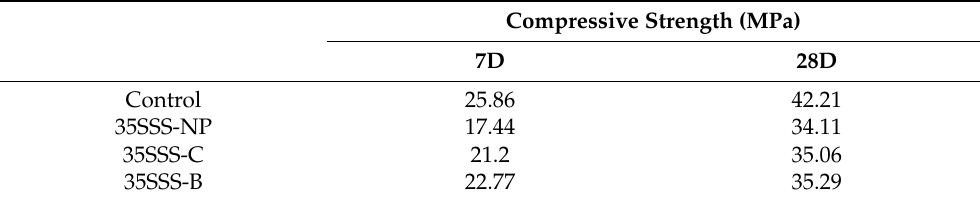
Table 7. Compressive strength of alkali-activated